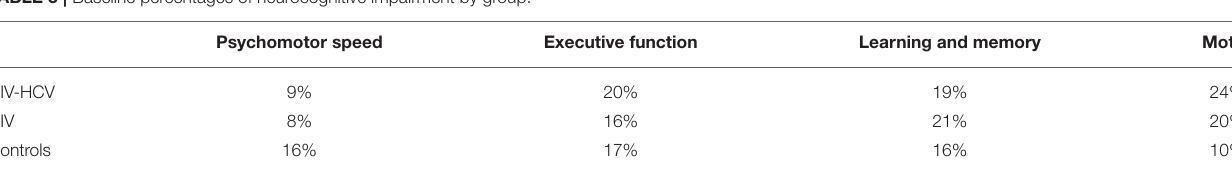
TABLE 3 | Baseline percentages of neurocognitive impairment by